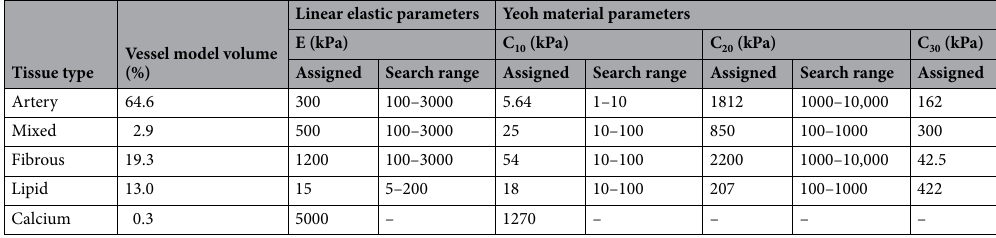
Table 1. Tissue prevalence, ground truth material parameters, and search bounds used for the patient-specific optimization routine in recovering linear elastic and Yeoh material